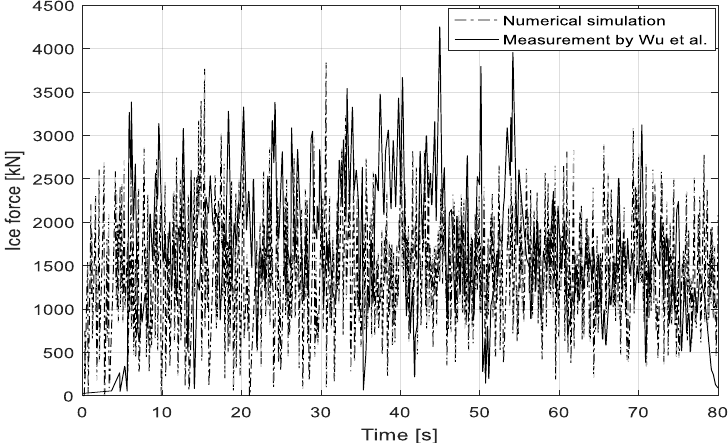
Figure 18. Time history of ice force from the measurement and simulation for test 404.